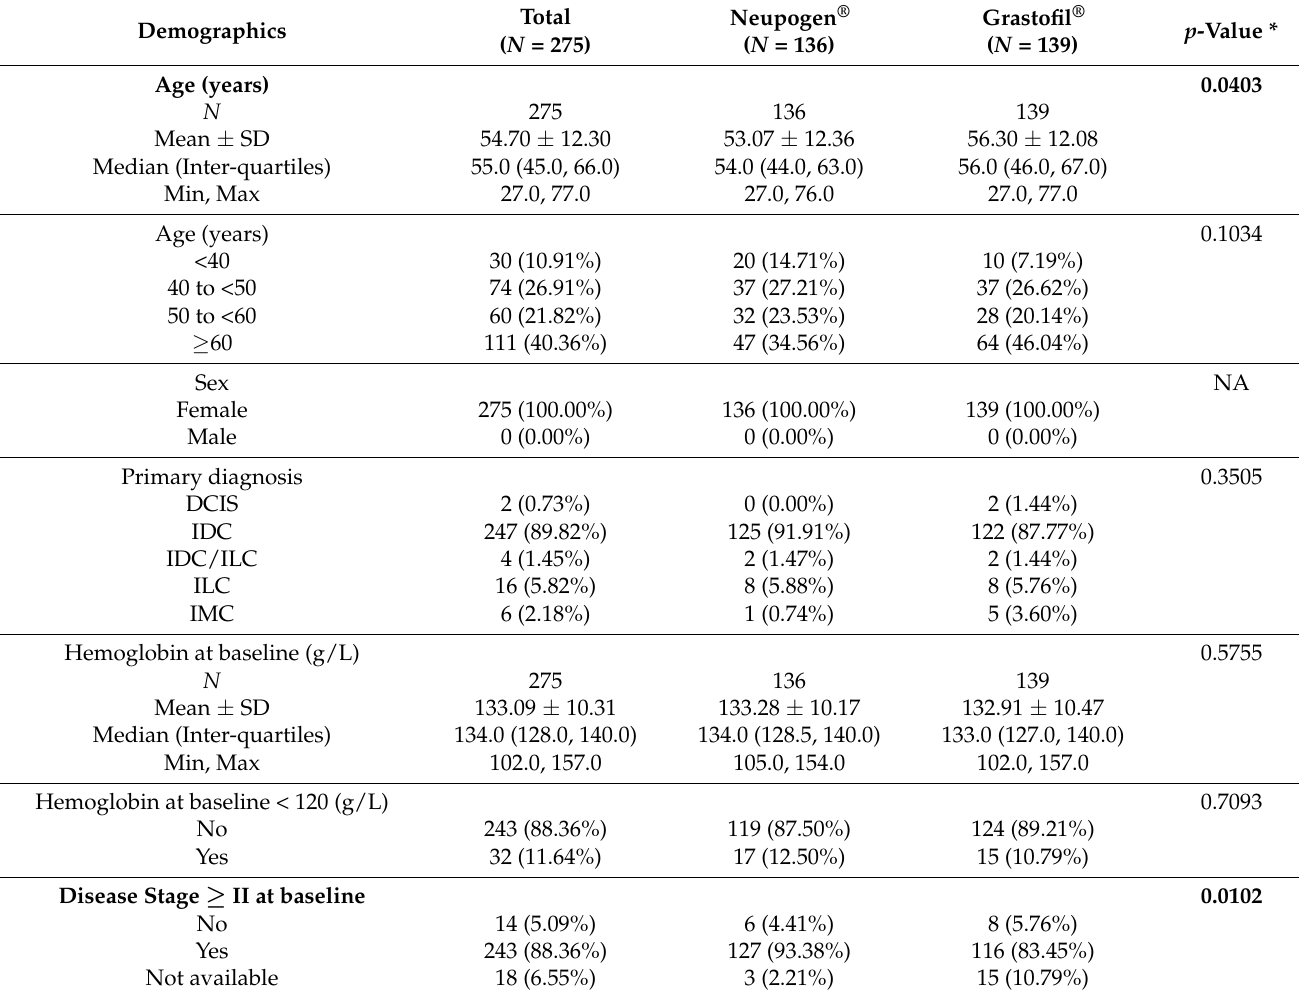
Table 2. Demographics in Breast Cancer Patients